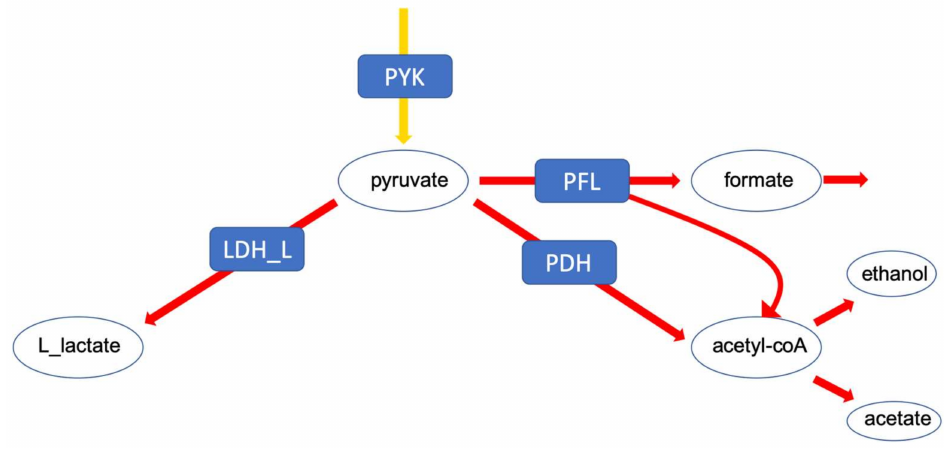
Figure 3. The pyruvate branching point. The distribution of flux at this point determines the fermentation profile of the cell.